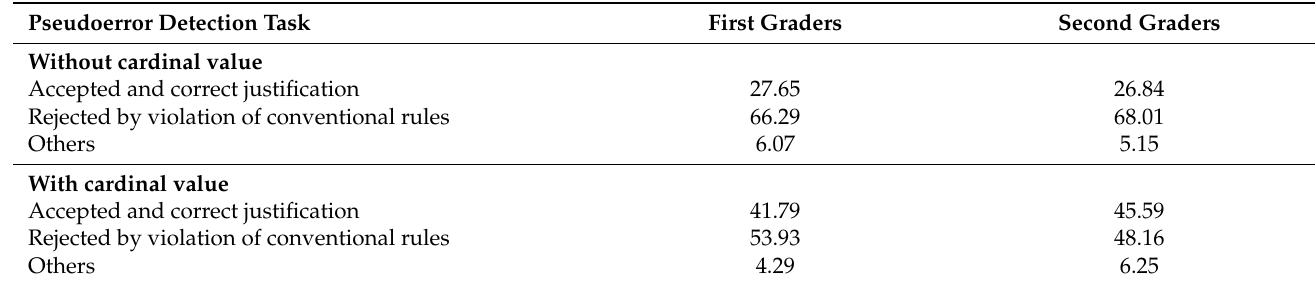
Table 5. Percentages of children’s justifications when detecting counting